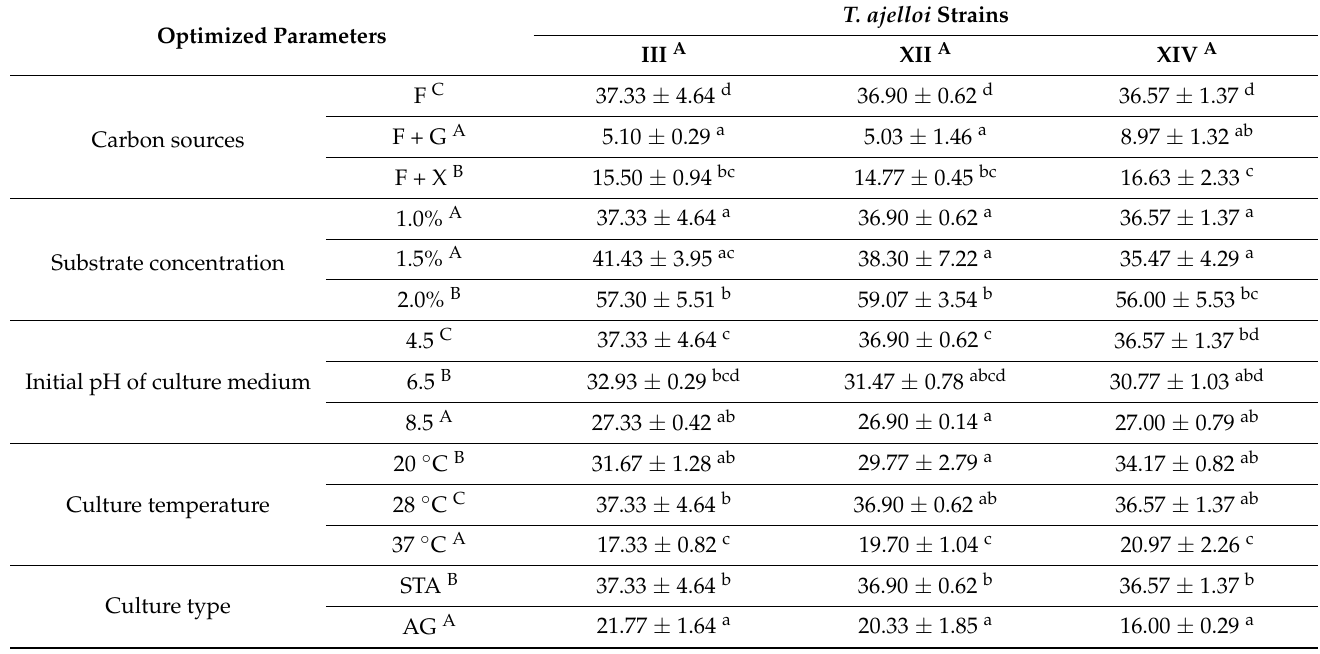
Table 4. Degree of keratin substrate degradation (%) by Trichophyton ajelloi fungal strains under various culture conditions and medium